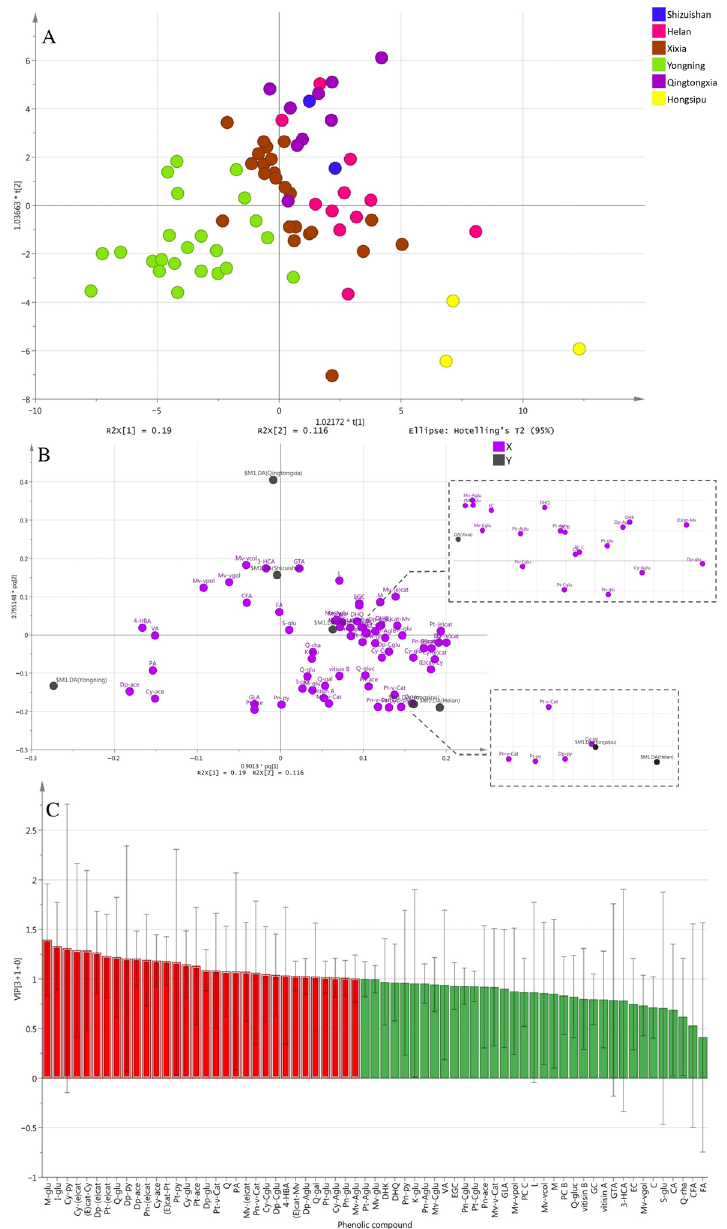
Figure 2. OPLS-DA model based on the concentrations of phenolic compounds in Cabernet Sauvignon wines from six sub-regions of EFHM. ( A ) Score plot ( B ) Loading plot ( C ) VIP plot of the OPLS-DA model.